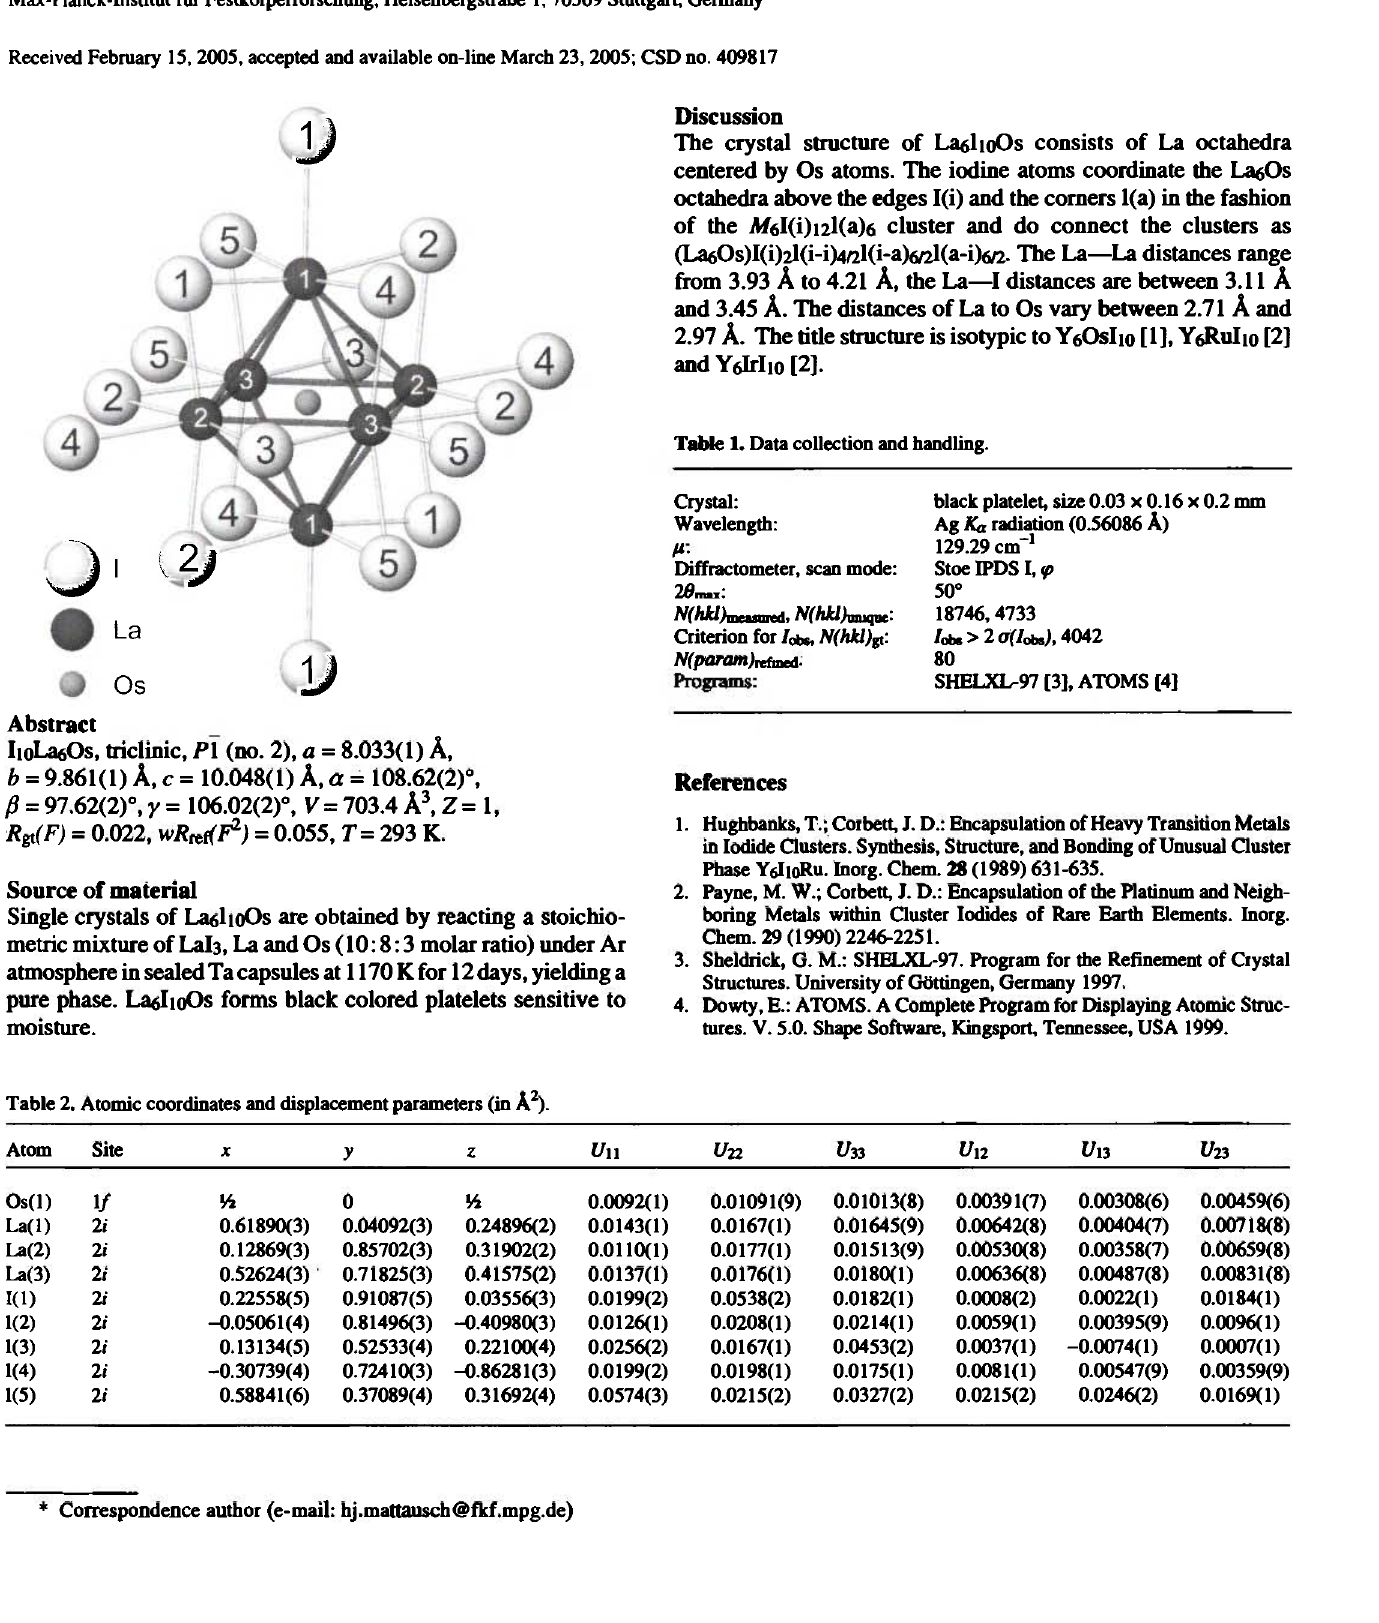
Table 2. Atomic coordinates and displacement parameters (in A 2